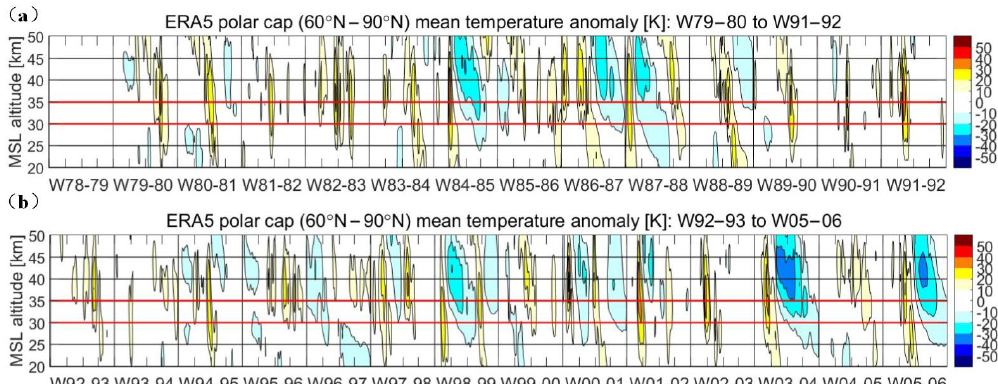
Figure 5. Temporal evolution of polar-cap-mean (60–90 ◦ N) daily mean temperature anomaly profiles from ERA5 over four winter months each (December, January, February, March) for the winters from W79–80 to W91–92 (a) and from W92–93 to W05–06 (b) , respectively. The W78–79 time period was not covered by the ERA5 dataset